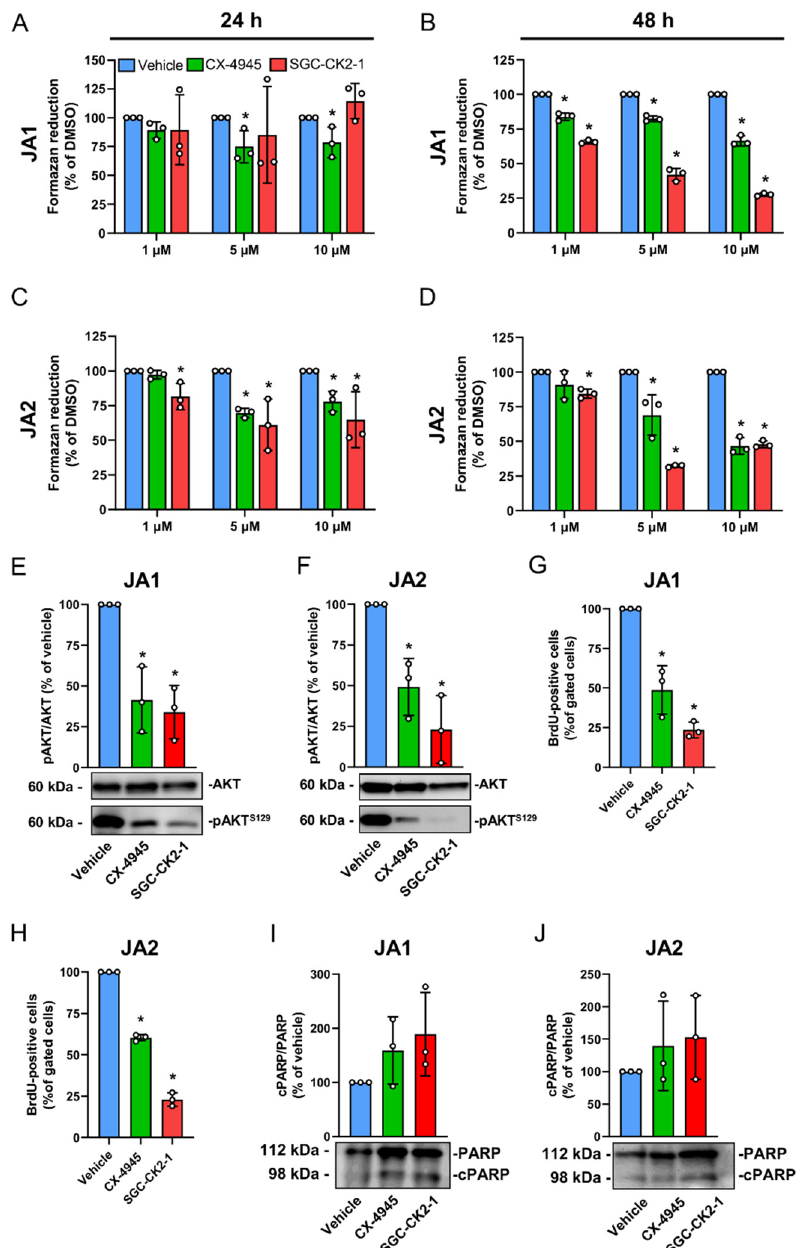
Figure 3. CK2 inhibition suppresses the proliferation of the JA cells. ( A – D ) The JA1 and JA2 cells were treated with the indicated concentrations of CX-4945 and SGC-CK2-1. The mitochondrial activity was measured by a WST-1 assay after 24 h and 48 h. Vehicle-treated cells served as controls and were set at 100%. Mean ± SD ( n = 3). * p < 0.05 vs. vehicle. ( E , F ) The JA1 and JA2 cells were treated with CX-4945 (10 µ M) and SGC-CK2-1 (5 µ M) for 48 h. Vehicle-treated cells served as controls. The cells were lysed and the expression of AKT and pAKT S129 was assessed by Western blot. The relative density ratio of pAKT S129 /AKT was determined and the vehicle-treated cells were set at 100%. Mean ± SD ( n = 3). * p < 0.05 vs. vehicle. ( G , H ) JA1 and JA2 were treated as described in ( E , F ) and the incorporation of BrdU was analyzed by flow cytometry. The BrdU-positive cells were expressed to all the gated cells and the vehicle-treated cells were set at 100%. Mean ± SD ( n = 3). * p < 0.05 vs. vehicle. ( I , J ) The JA1 and JA2 cells were treated with CX-4945 (10 µ M) and SGC-CK2-1 (5 µ M) for 48 h. Vehicle-treated cells served as controls. The cells were lysed and the expression of AKT and pAKT S129 was assessed by Western blot. The relative density ratio of cPARP/PARP was determined and the vehicle-treated cells were set at 100%. Mean ± SD ( n = 3).